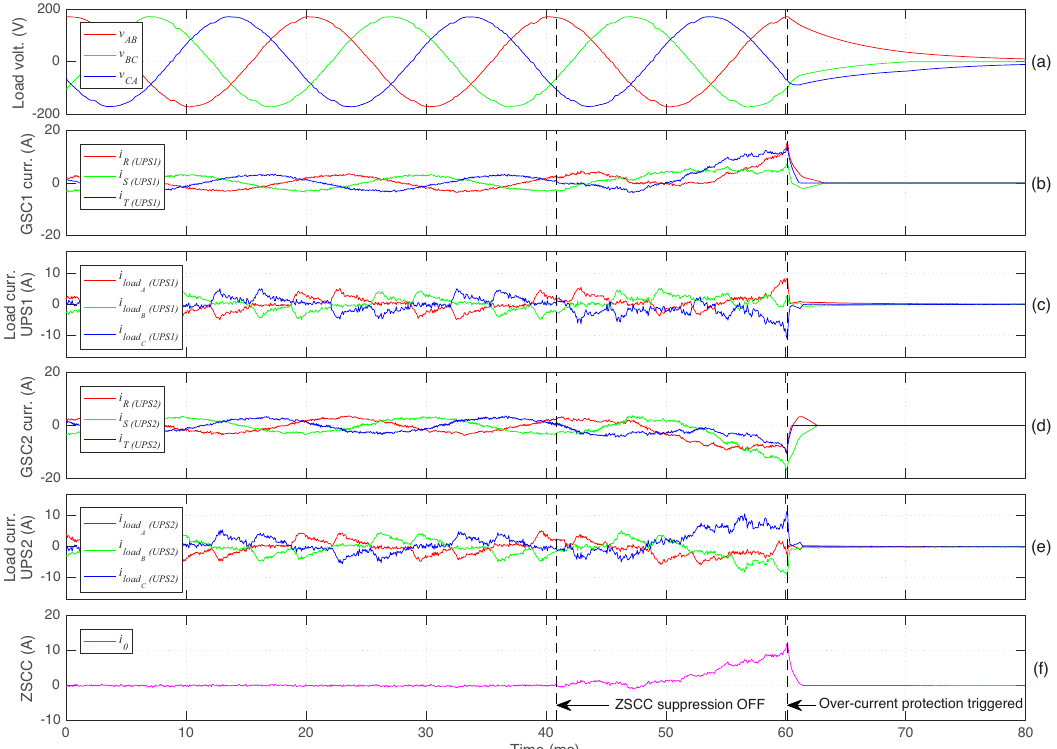
Figure 10. UPS systems performance during the deactivation of the ZSCC suppression: ( a )